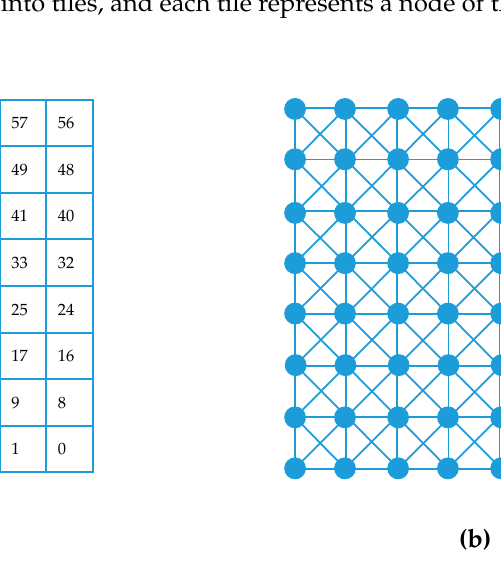
Figure 3. Layout of tiles: ( a ) Tiles with unique identifier numbers. Each tile represents a node of the graph. ( b ) Eight-way graph structure of nodes; eight-way connection defines left, right, up, down, and diagonal movements. Adjacent nodes are interconnected by the edges to make agents move toward one another.